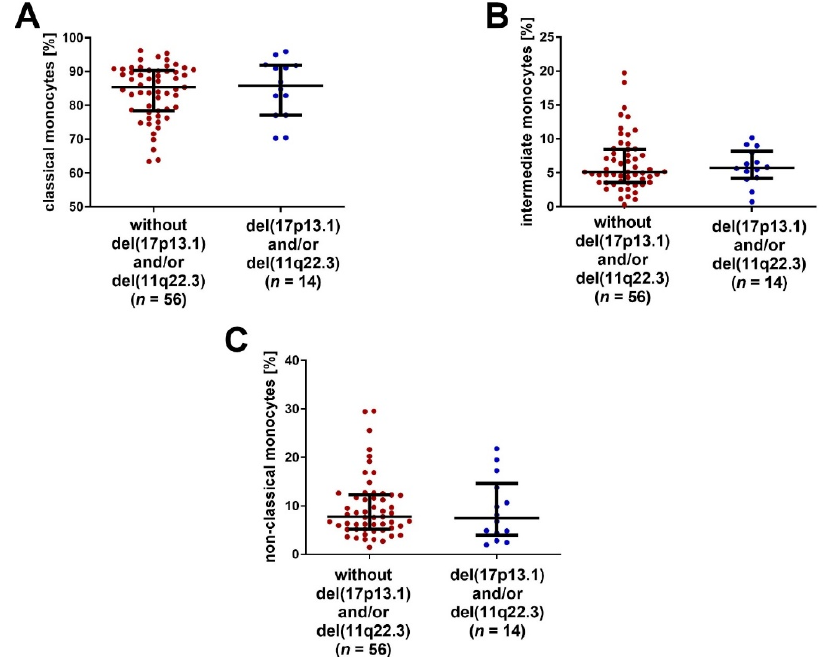
Figure 5. The percentage of monocytes ( A ) CD14 + CD16 − SLAN − , ( B ) CD14 + CD16 + SLAN − and ( C ) CD14 dim CD16 + SLAN + in the group of CLL patients with del (11q22.3) and/or del (17p13.1), and Figure 3. Comparison of the percentage of ( A ) classical, ( B ) intermediate and ( C ) non-classical mon- in the group of patients without these cytogenetic aberrations. The solid line marks the median value. ocytes in CLL patients at different stages of disease advancement. The solid line marks the median value. Ɪ represents the interquartile range